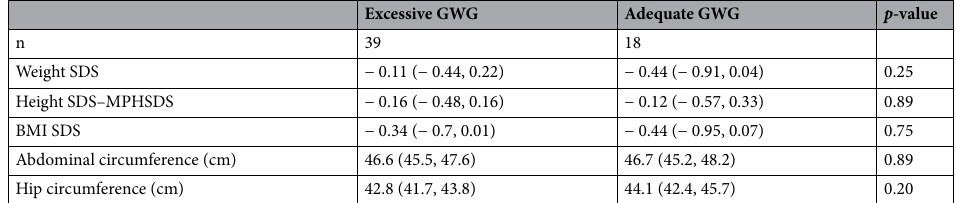
Table 4. Anthropometry at the 1-year follow-up in the offspring according to maternal gestational weight gain (GWG). Data are model-adjusted means and the respective 95% confidence intervals (CI) derived from general linear models, including maternal body mass index (BMI) in mid-gestation, and adjusted for child’s sex, age, and trial group allocation. MPHSDS, mid-parental height standard deviation score; SDS, standard deviation